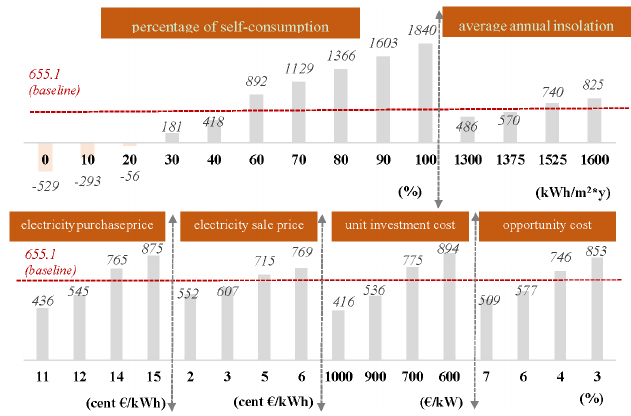
Figure 4. Sensitivity analysis–NPV (k€) for a 1 MW power system.